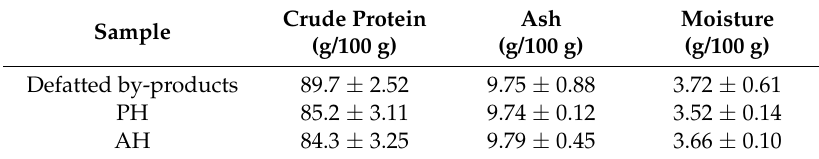
Table 1. Proximate composition of the defatted by-products and hydrolysates.